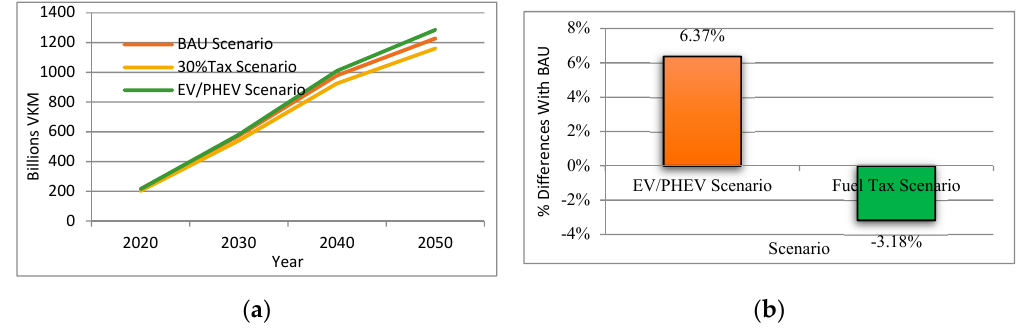
Figure 13. Comparison of VKM among the scenarios: ( a ) 2016–2050, and ( b ) 2050.